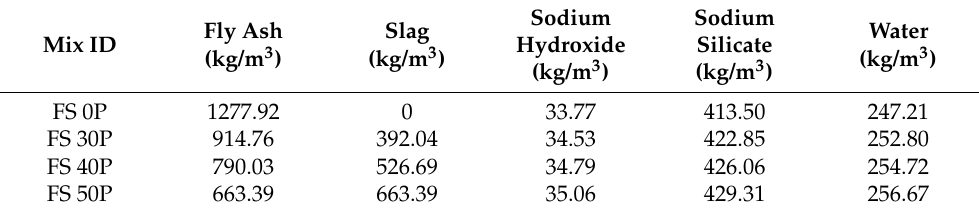
Table 2. Mix proportions of AAB paste.